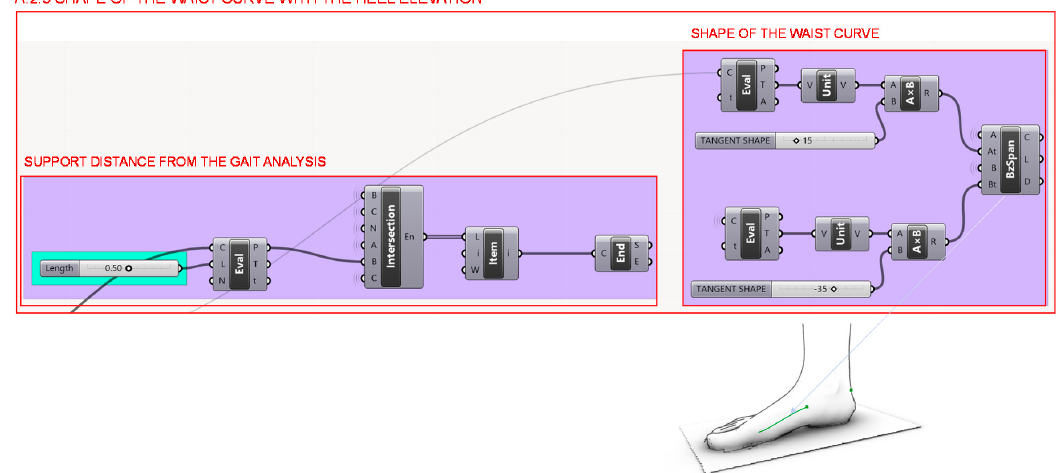
Figure 11. Programming structure definition developed to determine the shape of waist curve according to the chosen heel elevation.